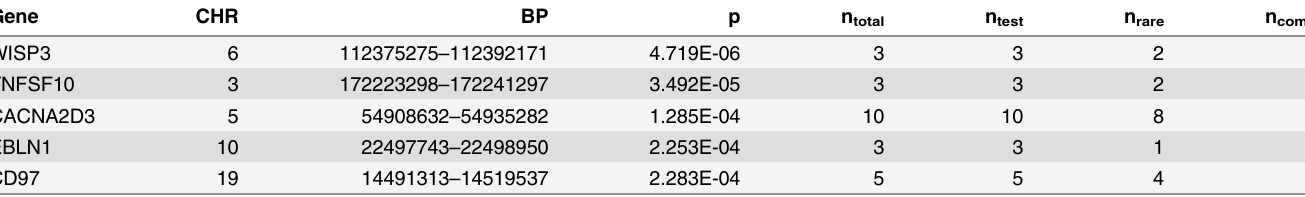
Table 3. Top 5 genes with at least 3 SNPs per gene from the SKAT CommonRare analysis, using the first 3 principal components as covariates.